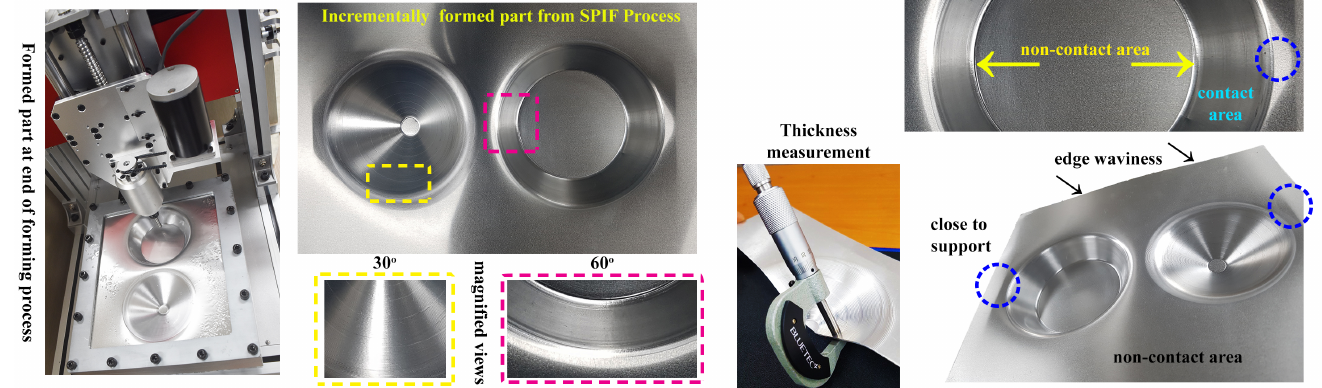
Figure 8. Incrementally formed truncated conical shape parts and thickness